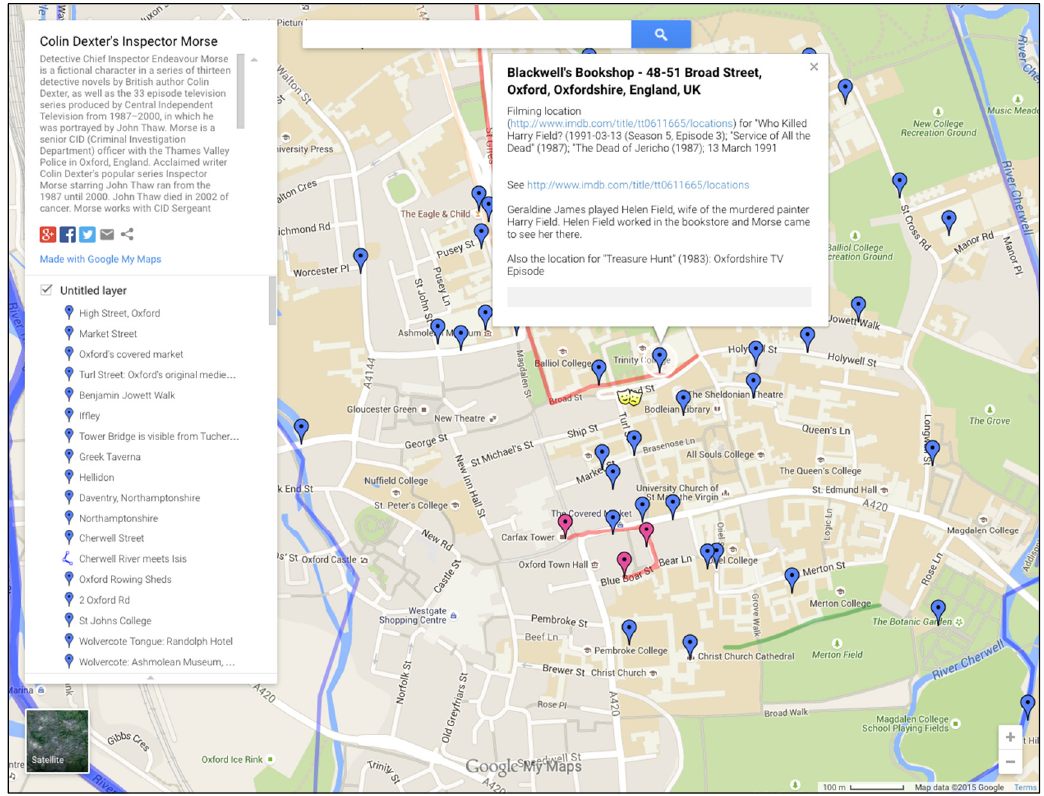
Figure 1. User-modified Google Map of “Colin Dexter’s Inspector Morse” [18]. ©2015